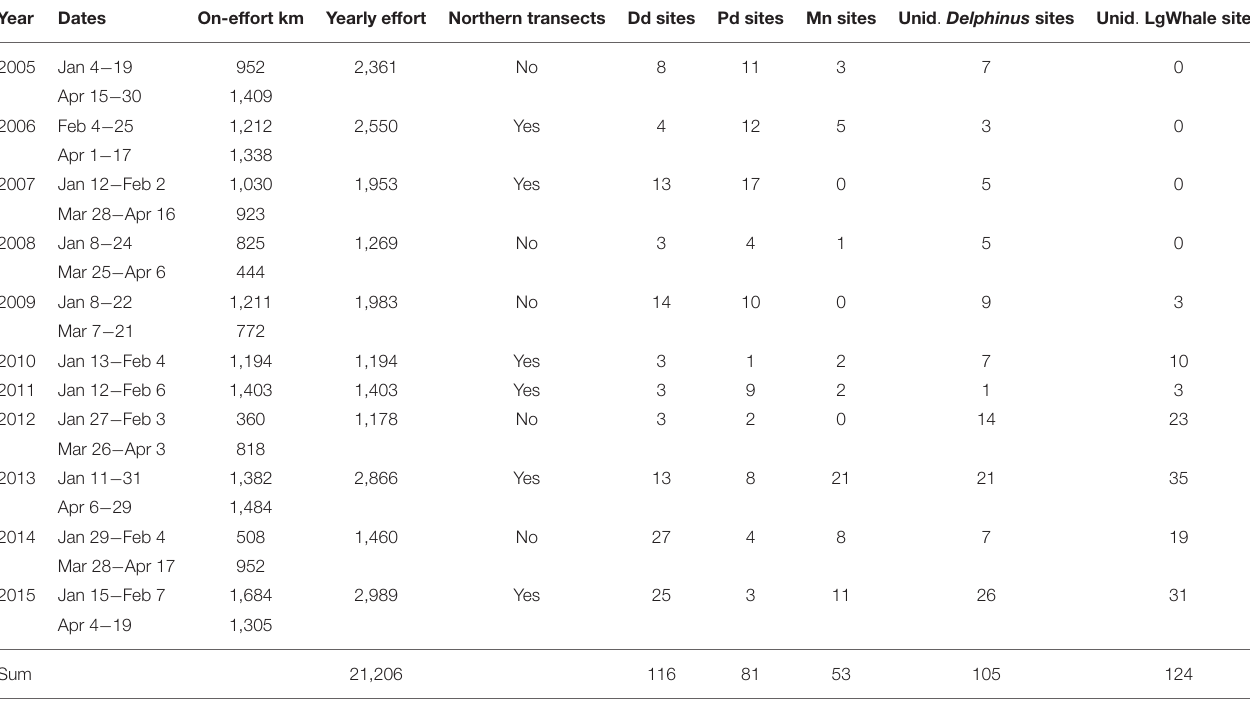
TABLE 1 | CalCOFI winter/spring survey data used to develop the habitat-based density models; on-effort km reflects the distance covered while two observers were on-effort on the main transects located roughly perpendicular to the coast in sea states ≤ 5. Year